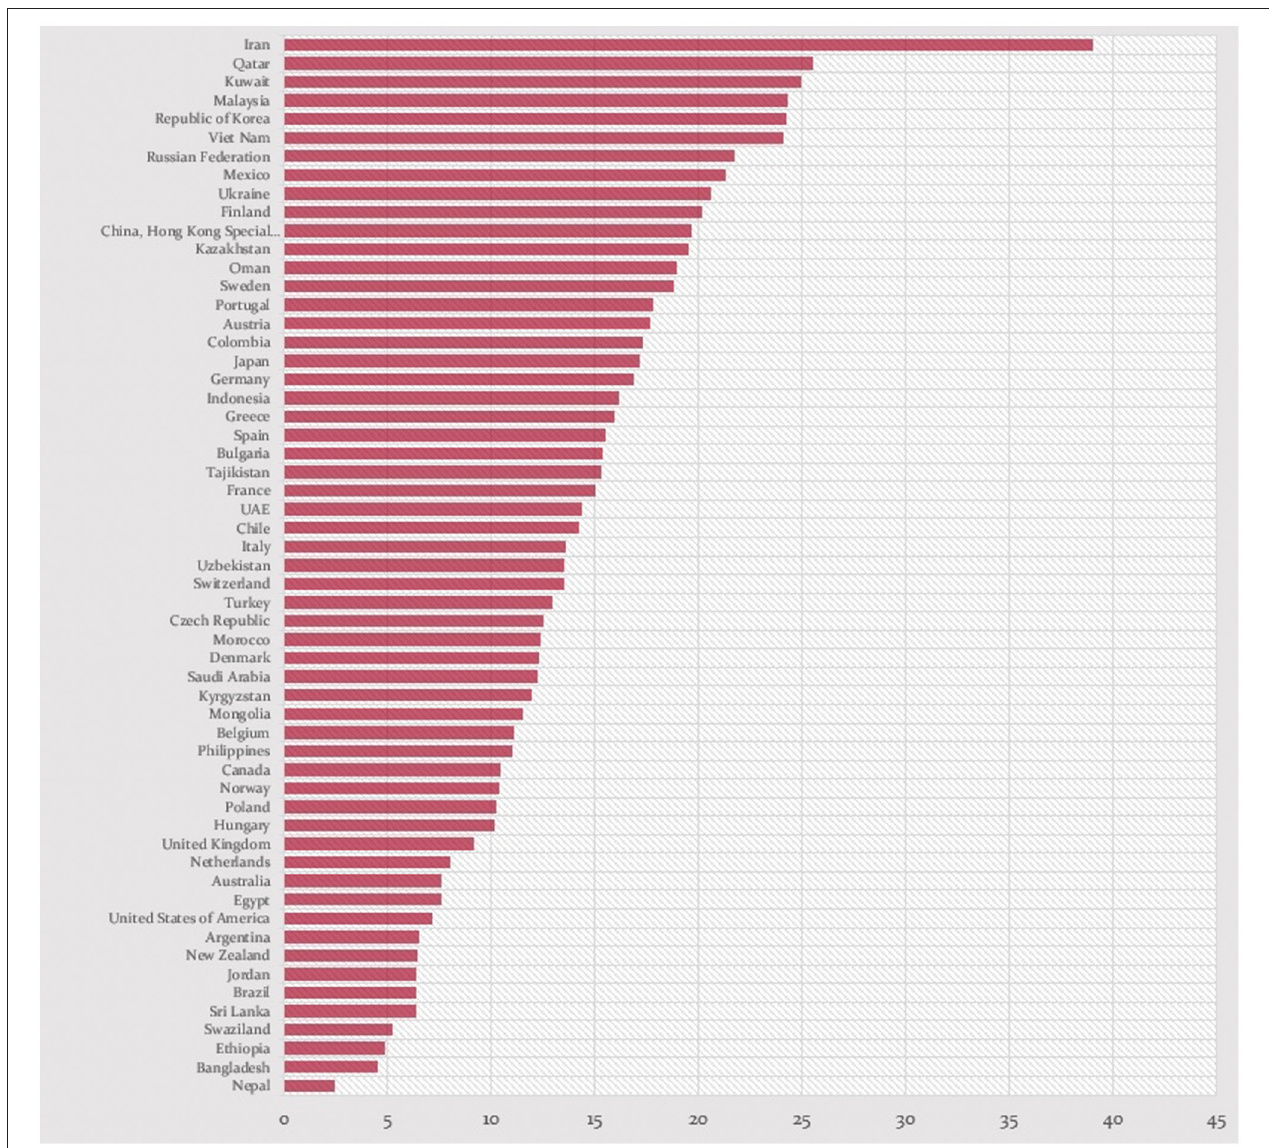
FIGURE 1 | The average percentage of graduates of Engineering, Manufacturing and Construction programs, both sexes (%) 2011–2013 (Data Source: World Economic Forum and UNESCO Institute for Statistics).